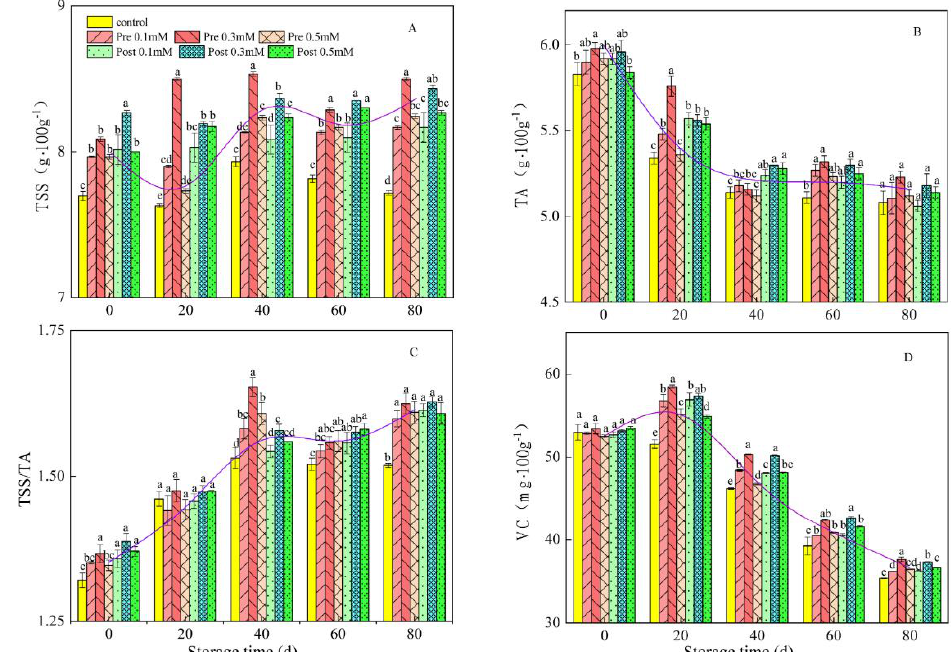
Figure 4. Effect of pre-harvest (Pre) and post-harvest (Post) methyl jasmonate treatments on the TSS (A), TA (B), TSS/TA ratio (C) and VC (D) in lemons in storage at 7 °C-10 °C. Data are the mean ± SE of three replicates of five fruit. Different lowercase letters show significant differences among treatments for each sampling date at p < 0.05 level.